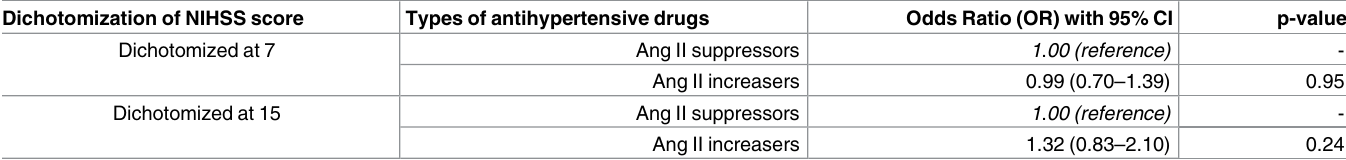
Table 2. Association between types of antihypertensive drugs and ischemic stroke severity (Dichotomized score). * † Dichotomization of NIHSS